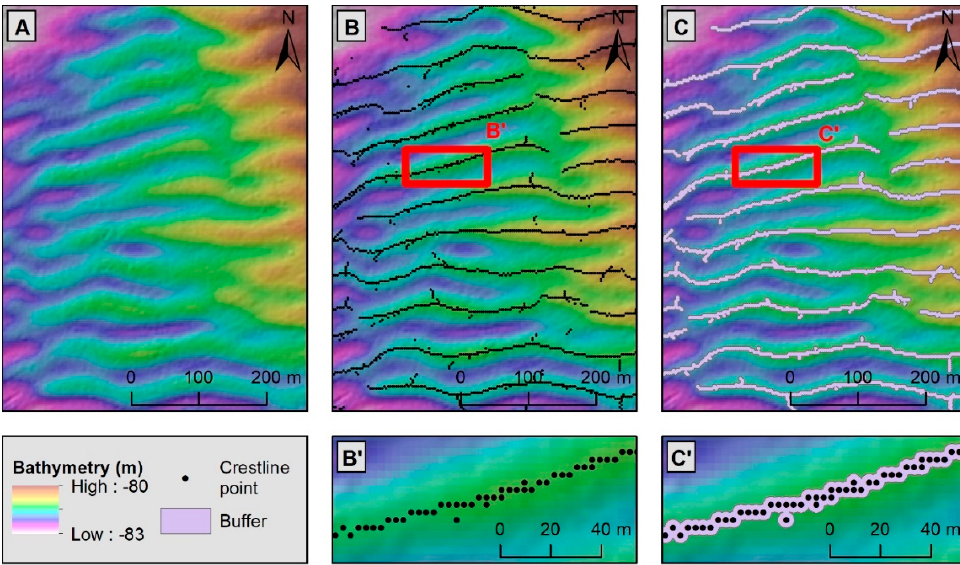
Figure 4. Identification of unique bedforms: The DEM ( A ) is scanned along x and y axis to identify crestline point ( B , B’ ). A buffer is generated around the crestline points, effectively generating polygons ( C , C’ ) with each polygon corresponding to a unique bedform crestline.